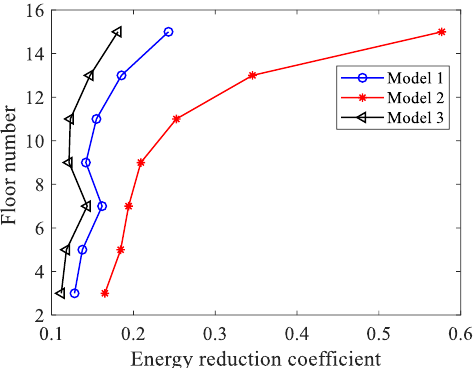
Figure 9. The energy reduction coefficient versus the position of the damping layer.